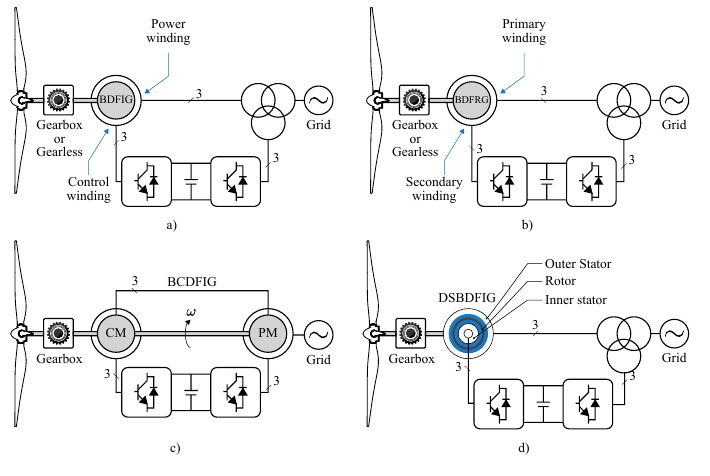
Figure 3. Different types of DFIG WECS configurations. ( a )BDFIG.( b )BDFRG.( c )BCDFIG.( d